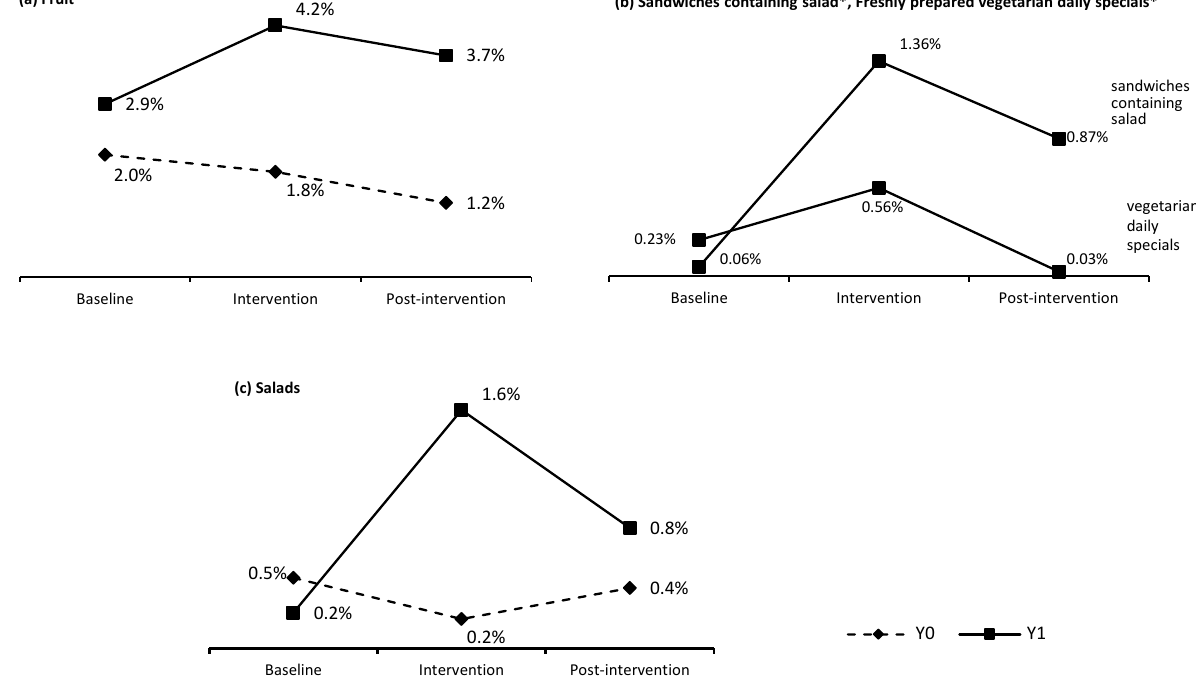
Figure 2. Selection of foods for baseline, intervention and post-intervention periods of Y1 ( n = 980) and the equivalent weeks during the previous year Y0 ( n = 1132), (number of items selected as a percentage of the relevant broad category): ( a ) fruit items (Y1:53,835; Y0:50,148 ‘sweet’ food items); ( b ) sandwiches containing salad, freshly prepared vegetarian daily specials (Y1:18,972 ‘main’ food items); and ( c ) salad items (Y1:76,168; Y0 86,849 ‘main’ food items). * baseline data limited to three